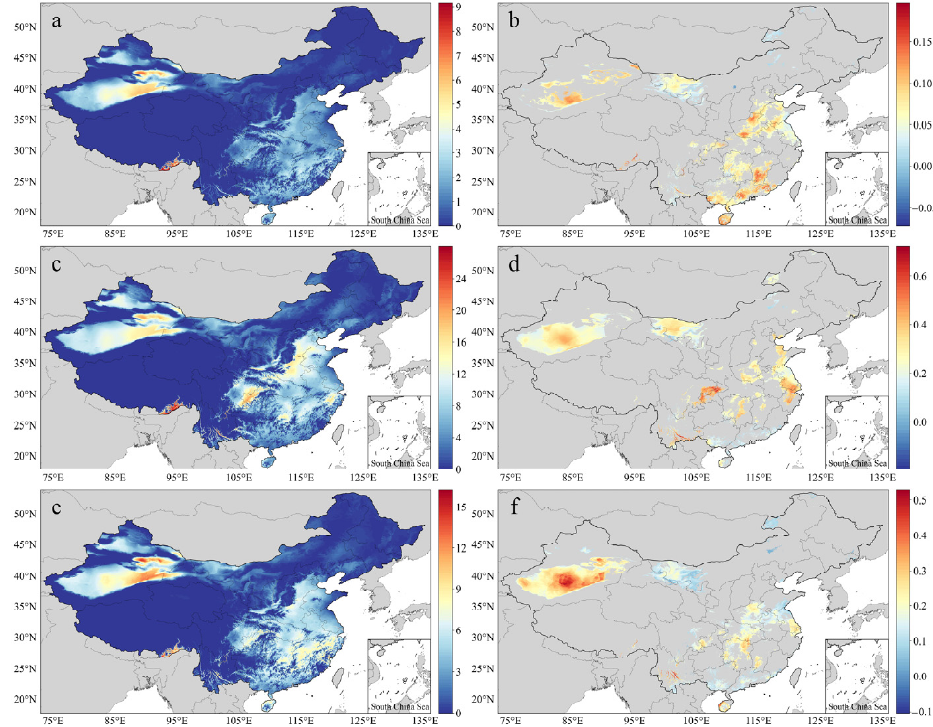
Figure 6. Spatial distribution of the averages and slopes of the HWF ( a , b ), HWMHI ( c , d ), and HWMD ( e , f ) for the years 1990–2019.